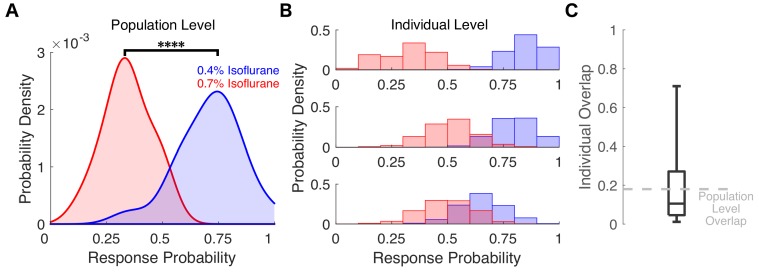
Varying degrees of overlap in response probability are present at the individual level between different isoflurane concentrations.(A) Probability density of the individual across-trial response probabilities were estimated for mice exposed to 0.4% isoflurane (blue) and 0.7% isoflurane (red). In contrast to results in Figure 6B where different populations of mice were used, here the same 20 mice were exposed to both 0.4% and 0.7% isoflurane. At the population level, distributions of responsiveness at the two isoflurane concentrations are significantly different (U = 7, n 0.4% iso = n 0.7% iso = 20, p < 0.0001). Overlap of the two distributions was 18%. (B) Probability density estimates of response probability to exposures of 0.4% (blue) and 0.7% isoflurane (red) were computed with a bootstrap resampling technique (1000 bootstraps for 20 trials with resampling). Representative probability density estimates of the same individual exposed to two drug concentrations highlighting the variability in response probability overlap across the two concentrations are shown, from marginal overlap (top), to some overlap (middle), to high overlap (bottom). (C) Boxplot representing fraction of overlap across individual mice. Box plot central mark indicates the median (11%), box shows interquartile range (5% to 27%), whiskers extend to the most extreme data points (1% and 71%). Statistical significance is shown by ****p < 0.0001. Source data for the response probability distributions described are available in the Figure 7—source data 1.Figure 7—source data 1.PC1 values for mice exposed to both 0.4% and 0.7% isoflurane.